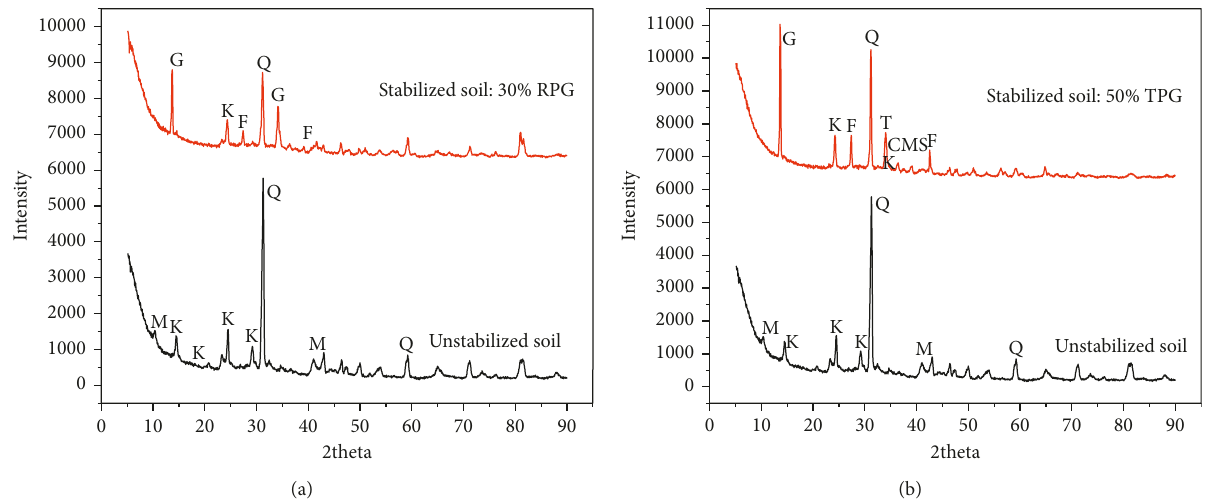
Figure 4: Mineralogy of expansive soil and stabilized soil by (a) raw PG (M: montmorillonite; B: bentonite; Q: quartz; G: gypsum; K: kaolinite; F: feldspar) and (b) treated PG (M: montmorillonite; B: bentonite; Q: quartz; G: gypsum; K: kaolinite; F: feldspar; TK: trikalsilite; CMS: calcium magnesium silicide; S: sillimanite).